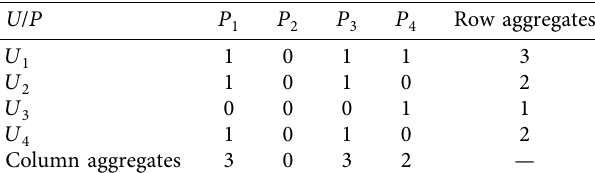
Table 3: Row aggregate set and column aggregate set.